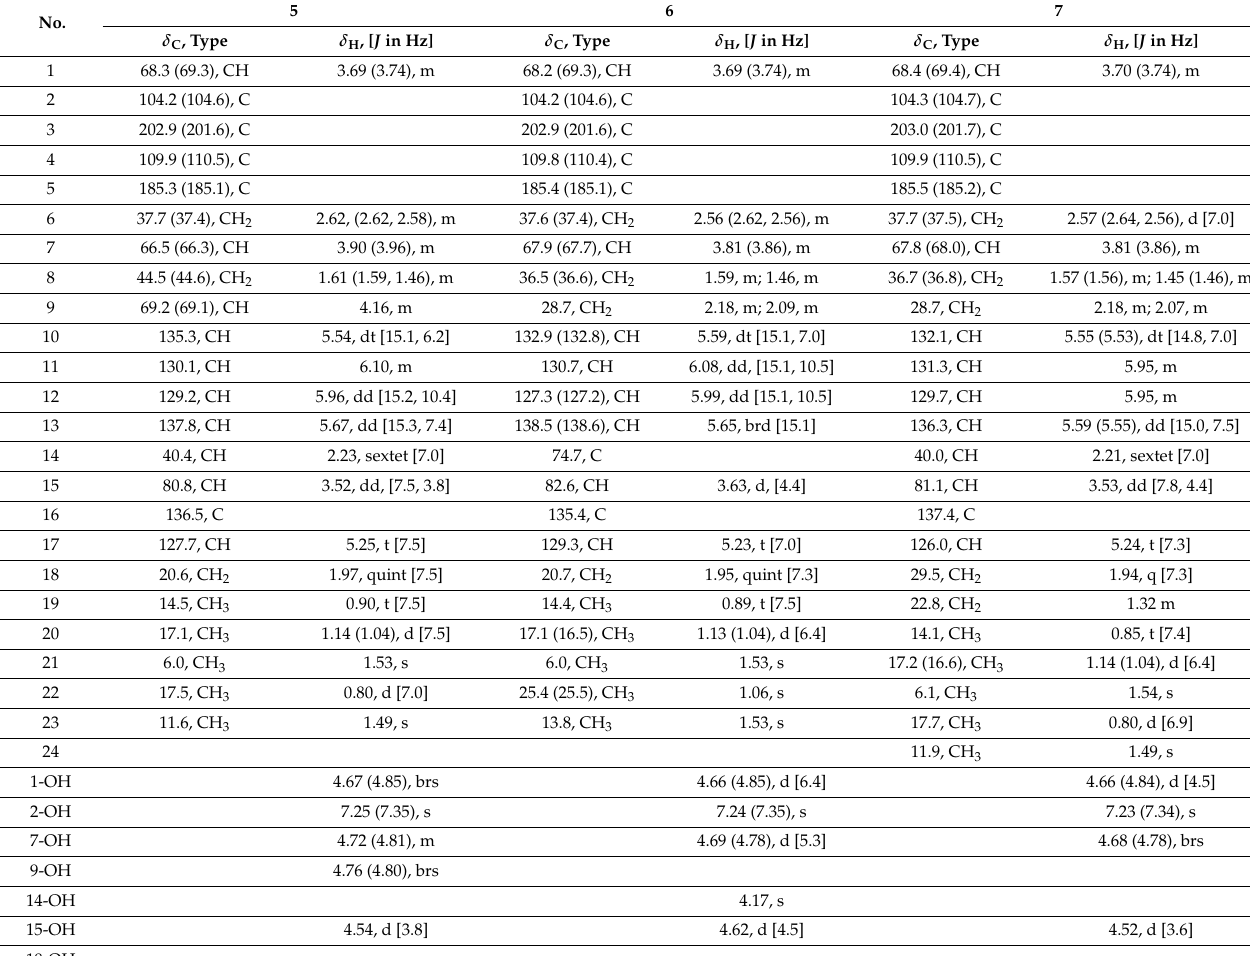
Table 3. 1 H-NMR (600 MHz) and 13 C-NMR (150 MHz) data of compounds 5 – 7 in DMSO- d 6